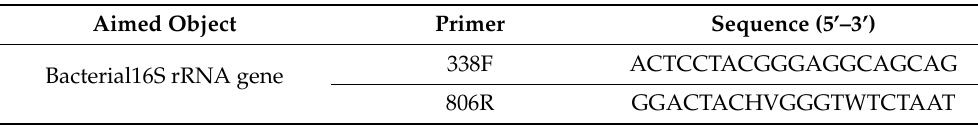
Table 2. PCR primer of bacteria.